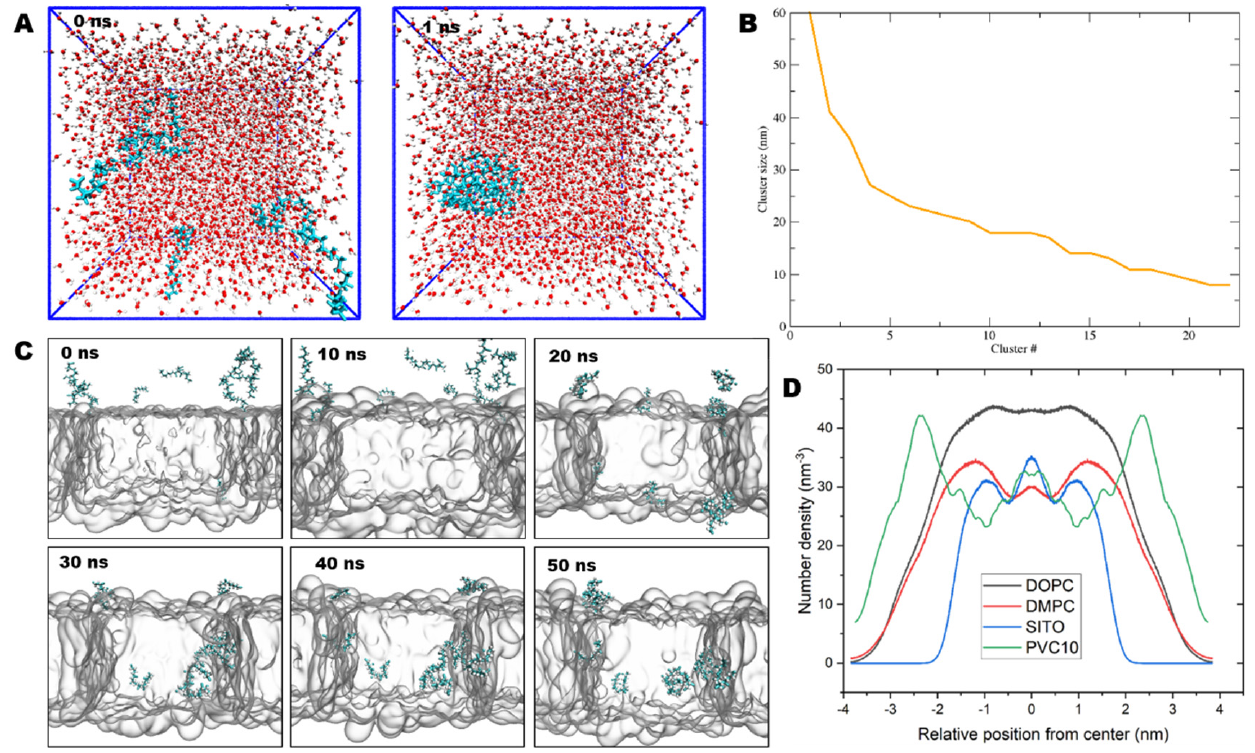
Figure 3. The process of PVC10 NP insertion into the lipid bilayer. ( A ) Snapshots of PVC10 monomers forming compact spheres in the water phase. ( B ) Distribution plot of NP cluster size in the water phase as a function of cluster number. ( C ) Snapshots of 50 ns MD simulations for the random and passive distribution of PVC10 NPs in the water phase above the bilayer. ( D ) Density profiles for the simulated lipid bilayer system in the presence of PVC10 NPs.